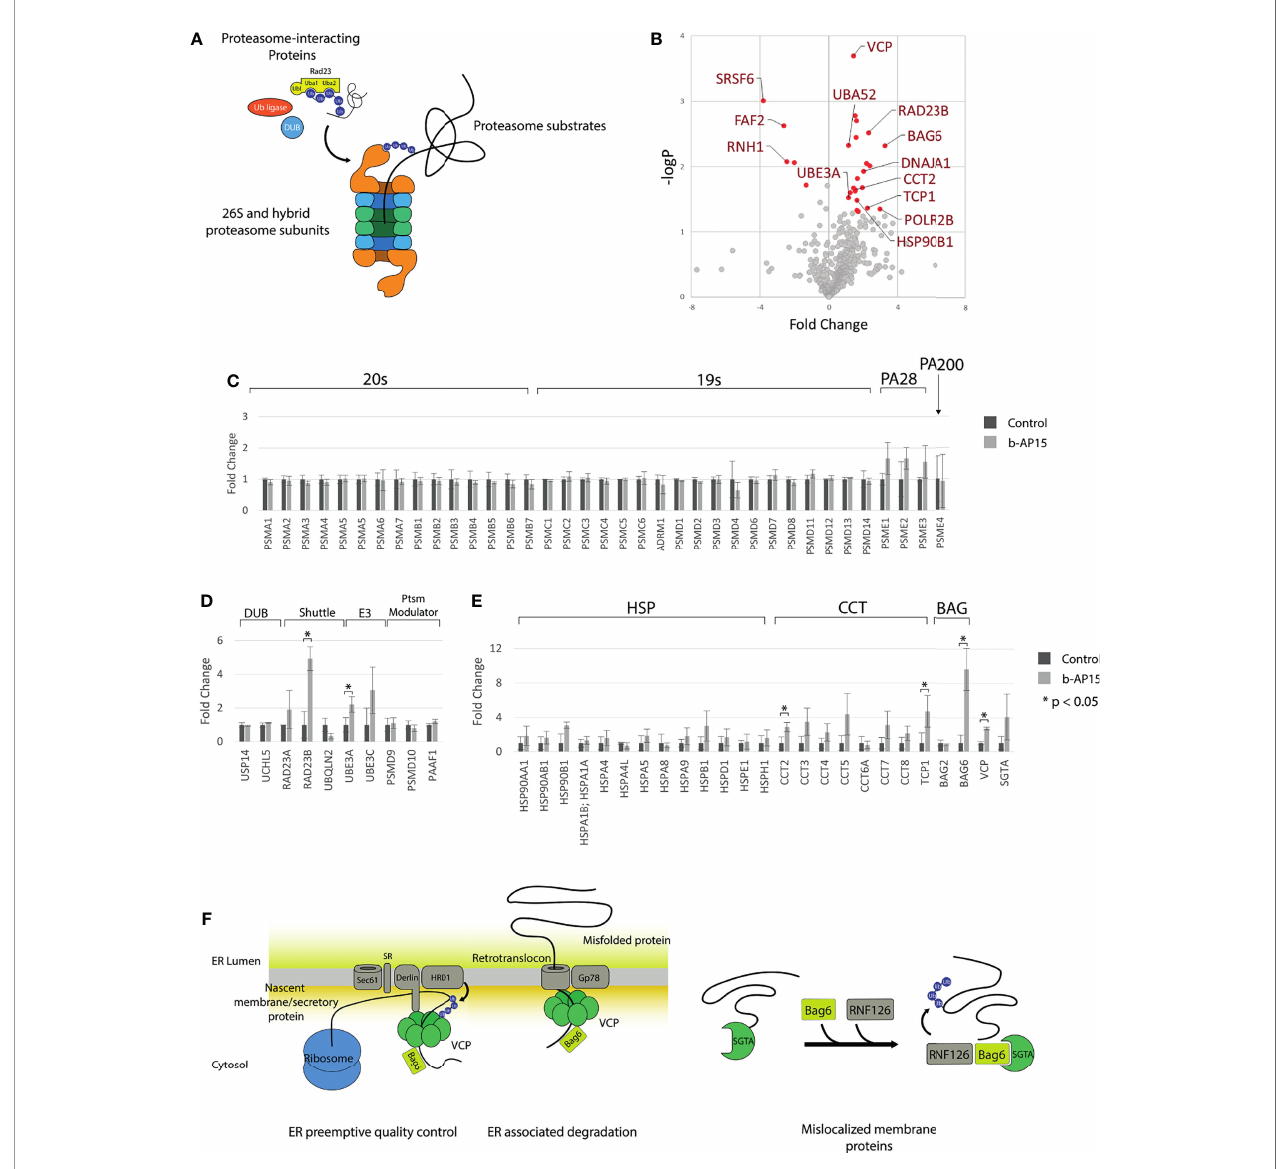
FIGURE 4 | Quanti fi cation of proteasome and proteasome-associated proteins. Proteasomes and proteasome-associated proteins were af fi nity puri fi ed from HEK293-Bio-Rpn11 treated with either DMSO or 1µM b-AP15 and processed for LC-MS/MS and label-free quanti fi cation. (A) Types of proteins pulled down with HBTH-tagged proteasomes (B) 653 of the 757 identi fi ed proteins could be quanti fi ed. Cutoff values for signi fi cantly different proteins are logFCs > 1 or < and p-value < 0.05 (C) Relative amounts of 20S core particle and the 19S core particle. PA28 subunits are collectively increased with b-AP15 treatment (paired t-test p = 0.002) (D) Relative amounts of proteasome interacting proteins are largely unchanged. The levels of the Uba-Ubl protein RAD23B and the E3 ligase UBE3A is increased with b-AP15 treatment. (E) Heat shock proteins and components of the TRiC/CCT complex are collectively increased (paired t-test p < 0.002 for both). (F) VCP, BAG6 and SGTA relay protein substrates to the proteasome in the different protein quality control processes. b-AP15 treatment results in stalling of the proteasome and co-puri fi cation of these proteins. *p <